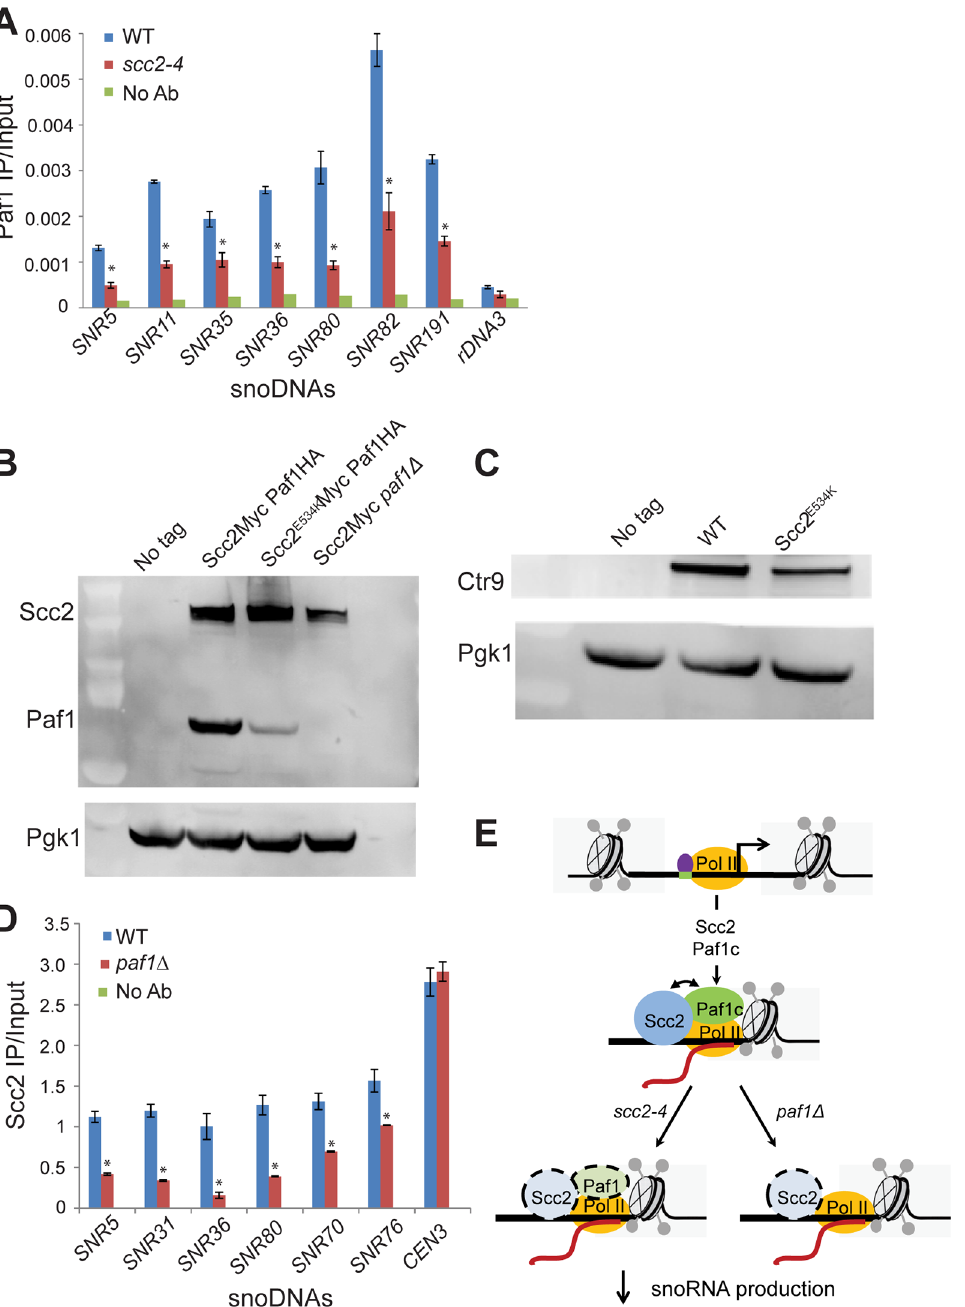
Fig 7. Scc2 and Paf1 recruitment at snoDNAs is co-dependent. (A) WT, scc2-4 , and paf1 Δ mutant strains were cultured in YPD medium to mid-log phase (~ OD 600 = 0.5 – 0.8). Strains were crosslinked and chromatin extracted for ChIP. ChIP/qPCR analysis was carried out for Scc2-Myc and Scc2 E534K -Myc and Scc2-Myc paf1 Δ . ChIP performed without the addition of primary antibody served as a negative control. ChIP experiments were performed at least three times. p-values were calculated using a student t-test. Standard error bars are indicated for n = 3. Values different from the WT are indicated by an asterisk (p < 0.05). qPCR analysis shows reduced enrichment of indicated snoDNAs in mutant relative to WT in Paf1 ChIP ( α -HA antibody, 12CA5, Roche). (B) Western blot analysis shows that the protein level of Paf1 is reduced in the scc2-4 mutant. Scc2 levels also appear reduced in the paf1 Δ strain. Pgk1 served as the loading control. (C) Western blot analysis shows that the protein level of Ctr9 is reduced in the scc2-4 mutant. (D) qPCR analysis shows reduced enrichment of snoDNAs in the Scc2-Myc ChIP in the paf1 Δ mutant strain relative to WT ( α -Myc antibody, 9B11, Cell signaling). (E) A cartoon model for the co-recruitment of Scc2 and Paf1 at snoDNAs is shown. The Tbf1 transcription factor is shown in purple, RNA Pol II in yellow, and Scc2 and Paf1c in blue and green,